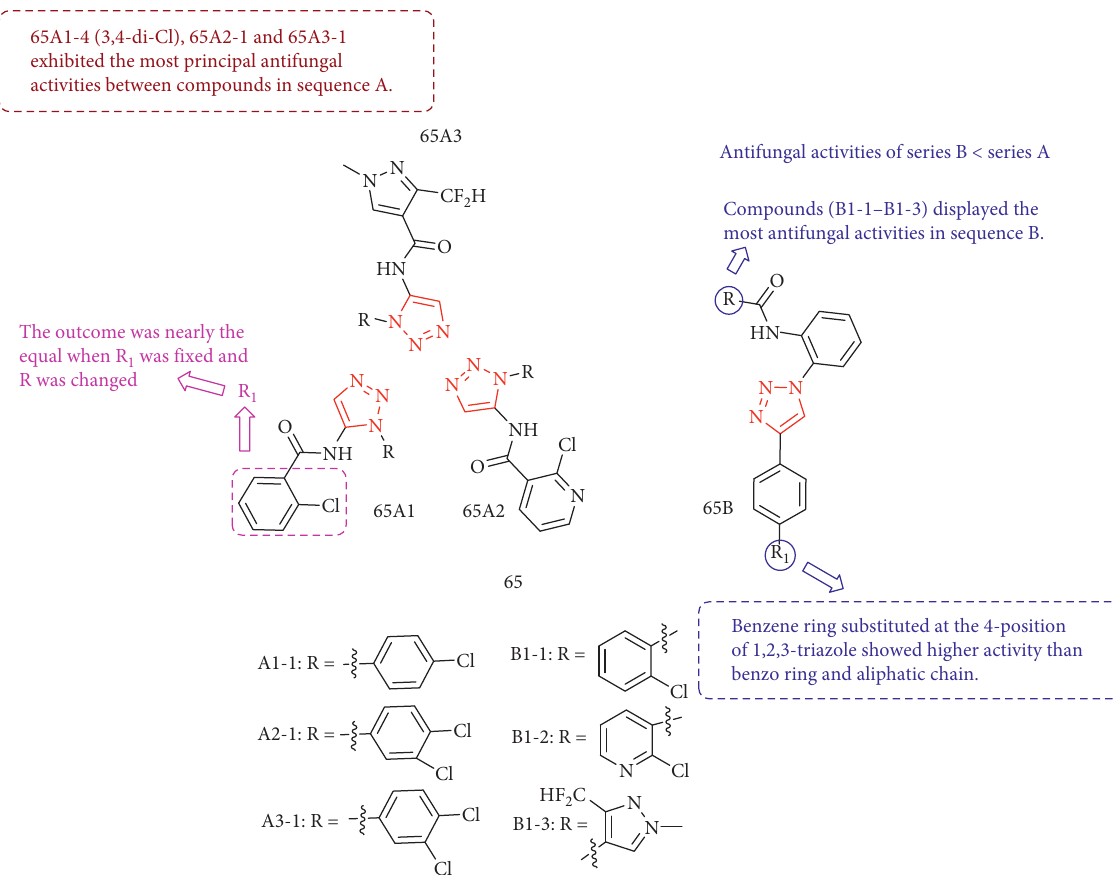
Figure 20: Chemical structure of carboxamide derivatives containing 1,2,3-triazole ring.